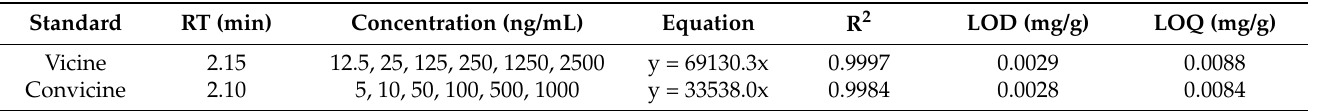
Table 2. Retention time, linear range, limit of detection (LOD) and limit of quantitation (LOQ) of the